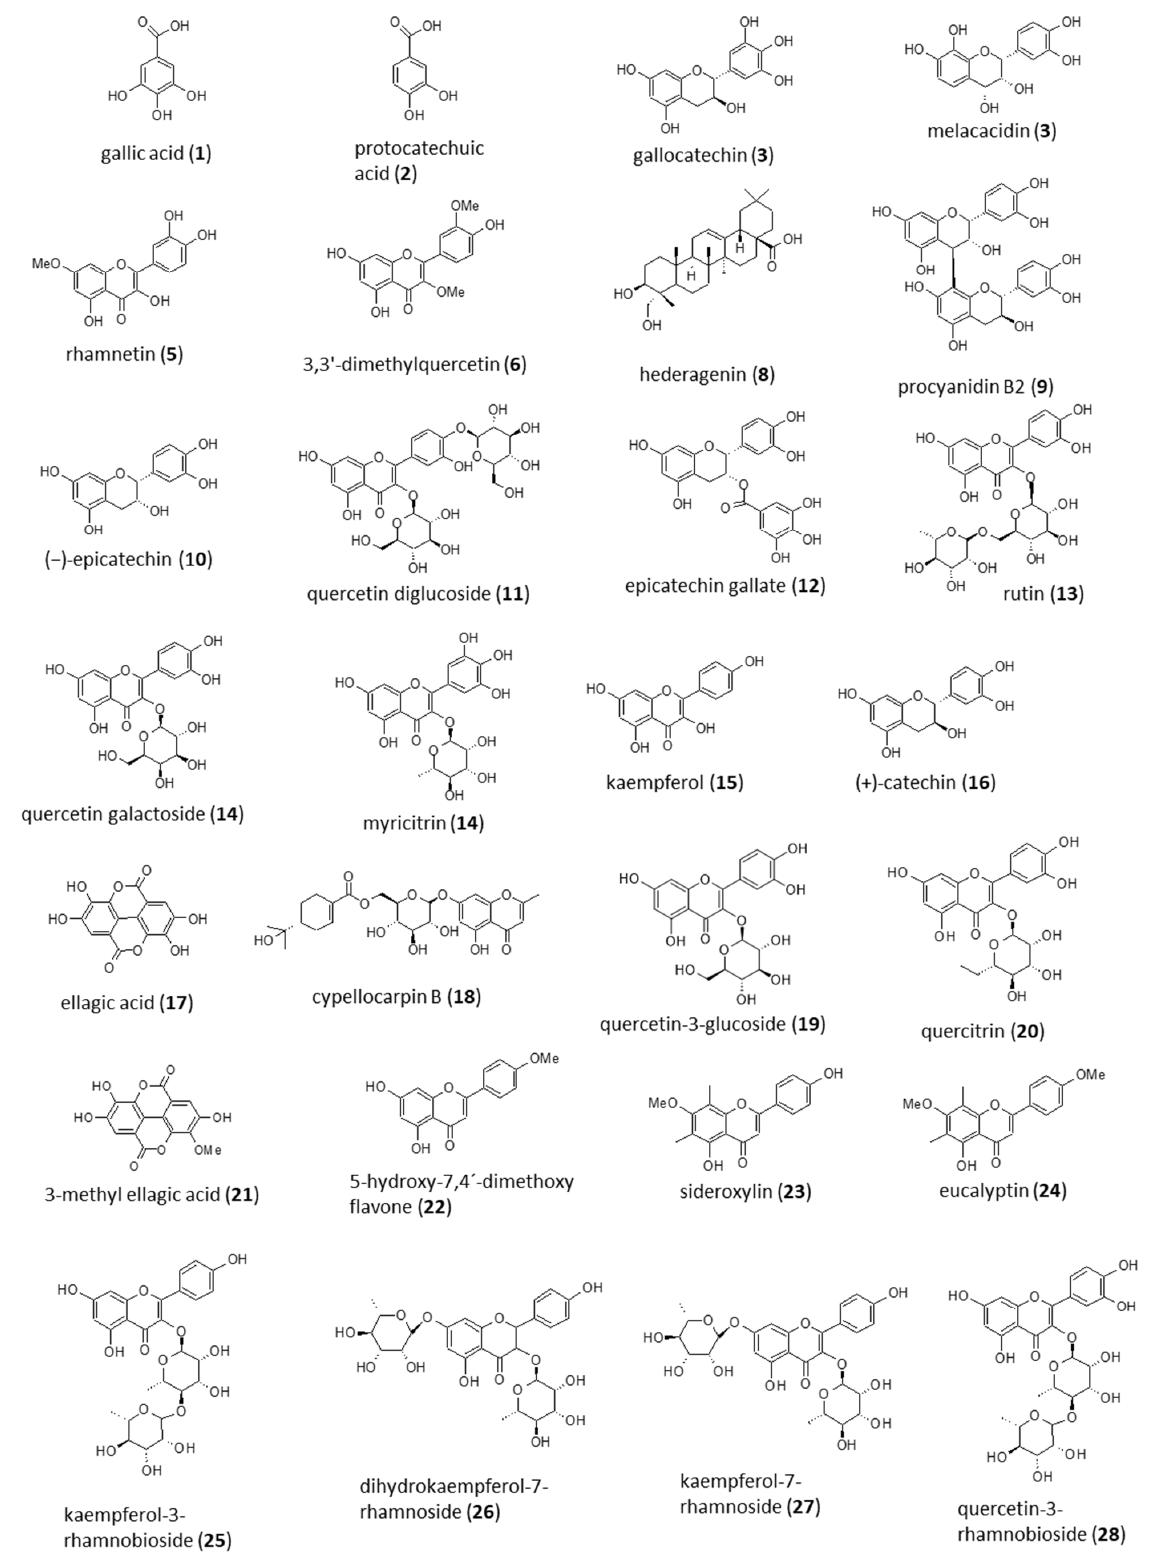
Figure 5. Structures of compounds putatively annotated in crude extracts and fractions of A. implexa bark, A. implexa leaves, E. rossii leaves and E. cupressiformis leaves. (Figure prepared with ACD/ChemSketch (Freeware) 2021.1.2).